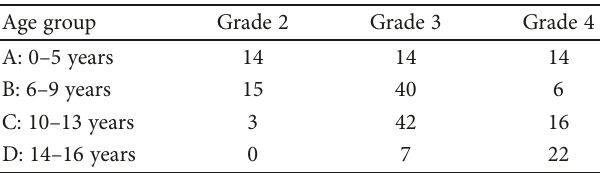
Figure 1: (a) Canine puri fi ed adipose MSCs at 20x magni fi cation. (b) Di ff erentiation assay chondrogenesis stained by Alcian blue. (c) Osteogenesis, alkaline phosphatase-positive colonies stained with Alizarin Red. (d) FACS analysis of the cultured canine adipose MSCs. Two positive and two negative CD markers for MSCs were used to identify the cells. MSCs were positive for CD90 and CD44 and negative for CD34 and CD45 cell Table 2: Osteoarthritis grade evaluated by the vets prior to CAD- MSC treatment.